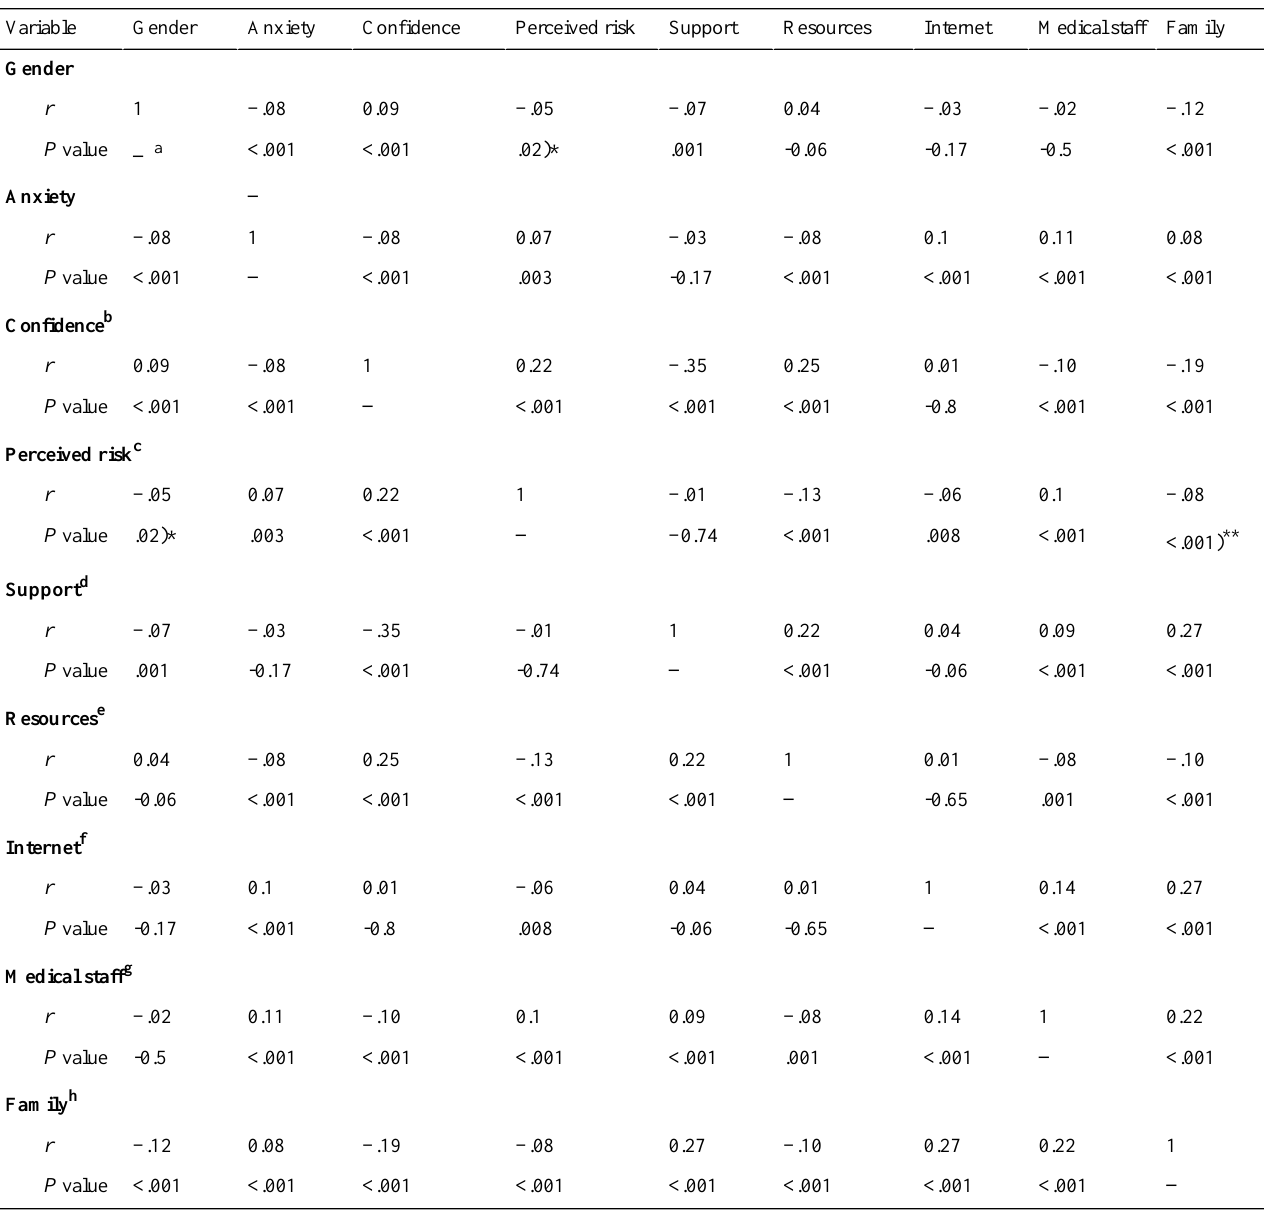
Table 2. Correlation matrix (Pearson r and 2-tailed P values) for studied variables